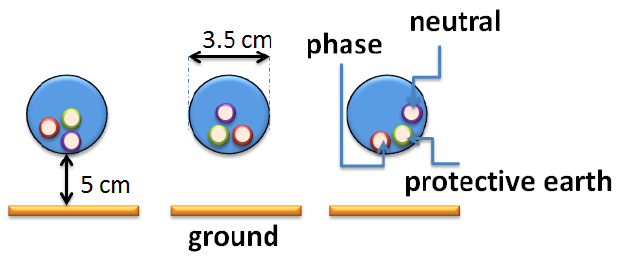
Figure 2: Random cable cross-sections (limited to three cross-sections for graph readability)